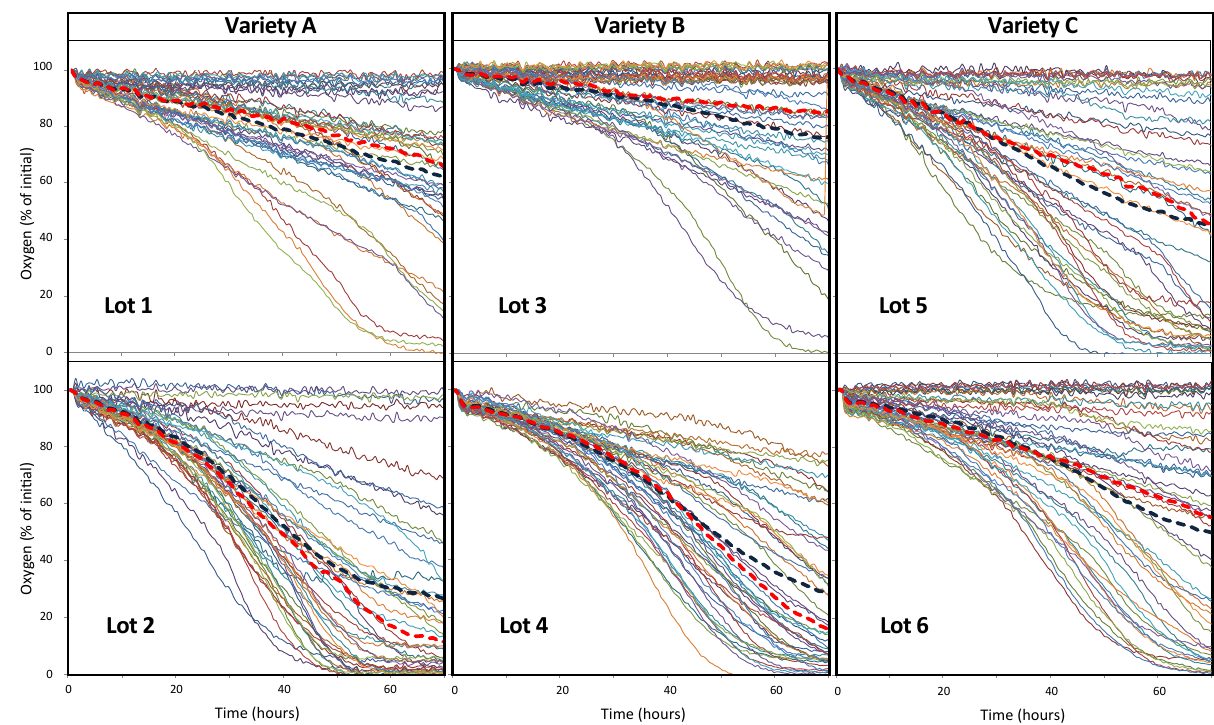
Figure 5. Oxygen depletion curves for individual seeds of kohlrabi seed lots tested at 15 ◦ C for 72 h after blindness induction treatment at 1.5 ◦ C for 48 h. Dashed lines represent the median (red) and average (black) oxygen depletion time courses for the entire seed